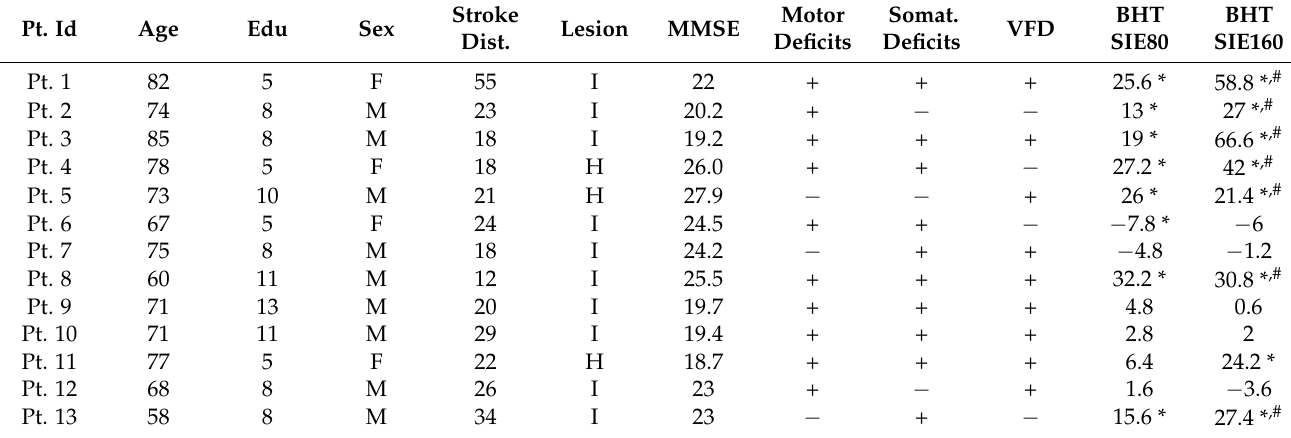
Table 1. Demographic, neurological, and neuropsychological characteristics of USN patients at first examination (T1). Pt. Id